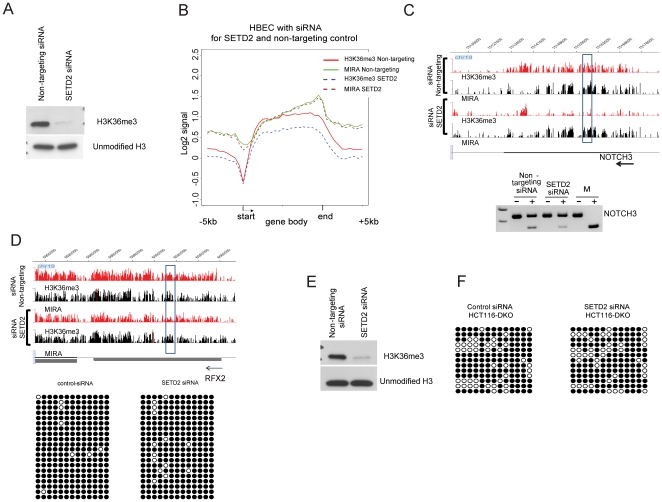
Epigenetic changes after SETD2 knockdown.
A. Western blot for HBEC cells after non-targeting siRNA and SETD2 siRNA transfection using anti-H3K36me3 antibodies and unmodified histone H3 antibodies. B. Composite profile of epigenetic changes after SETD2 siRNA knockdown in HBEC. The profile was created for gene bodies marked by H3K36me3 and DNA methylation over at least 20% of gene body length. Each gene body was divided into 20 bins and the 5 kb upstream of the TSS and 5 kb downstream of the 3' gene end were divided into 10 bins. The average signal for each single bin is indicated. C. Analysis of DNA methylation in the gene body of the NOTCH3 gene in conditions of H3K36me3 deficiency. The H3K36me3 profile of NOTCH3 after non-targeting siRNA and SETD2 siRNA transfections in HBEC cells is shown. The region analyzed by COBRA methylation assays is indicated by a box. Using gene-specific primers, bisulfite-converted DNA was amplified. After cutting with HpyCH4IV recognizing CpG dinucleotides, mock (-) and enzyme-digested (+) PCR products were fractionated on a 2% agarose gel. In vitro CpG-methylated human DNA (M) served as a positive control. Cleavage indicates DNA methylation. D. Analysis of H3K36me3 and DNA methylation in the gene body of RFX2 in conditions of H3K36me3 deficiency. The region analyzed by bisulfite sequencing is marked by a box. Using gene-specific primers, bisulfite-converted DNA was amplified, cloned and 20 individual clones were sequenced. White circles, unmethylated CpG sequences; black circles, methylated CpG sequences. E. Western blot for HCT116-DKO cells after non-targeting siRNA and SETD2 siRNA transfection using anti-H3K36me3 antibodies and unmodified histone H3 antibodies. F. DNA methylation analysis of the gene body of NOTCH3 after non-targeting siRNA and SETD2 siRNA transfection of HCT116-DKO cells. Using gene-specific primers, bisulfite-converted DNA was amplified, cloned and 13 individual clones were sequenced. White circles, unmethylated CpG sequences; black circles, methylated CpG sequences.